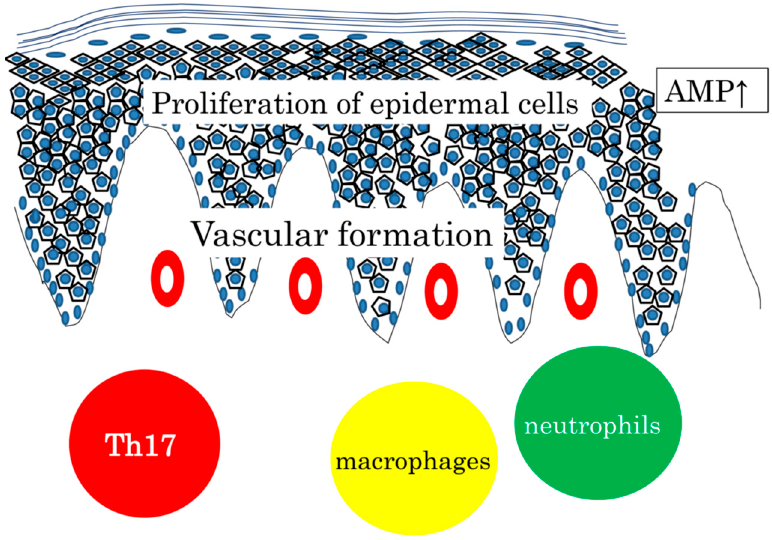
Figure 1. Proliferation of epidermal cells, AMP expression, vascular formation, and infiltration of Th17, neutrophils, and macrophages, commonly seen in wounded skin and in psoriasis skin. We sometimes experience fungal infection in patients treated with anit-IL7A or anti-IL17 receptor A antibody. Considering that Th17 cytokines are expressed in various skin diseases with barrier dysfunction and that antibodies against IL-12/IL-23p40 or IL-17A are not effective for AD, IL-17 and its related cytokine expression can be regarded as a common defense mechanism in the skin. Relatively low AMP expression leads to a higher risk of infection seen in AD and CTCL [77,78]. Targeting the Th17 cytokine has been successful for psoriasis, but may not be always the case in other skin diseases.